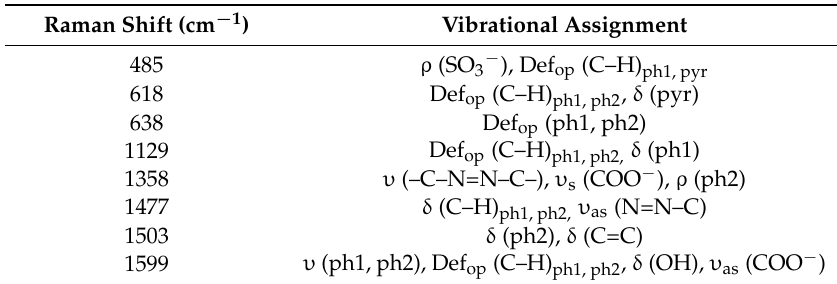
Figure 1. Raman spectrum of tartrazine. Table 1. Major band assignment of Raman spectra for tartrazine.